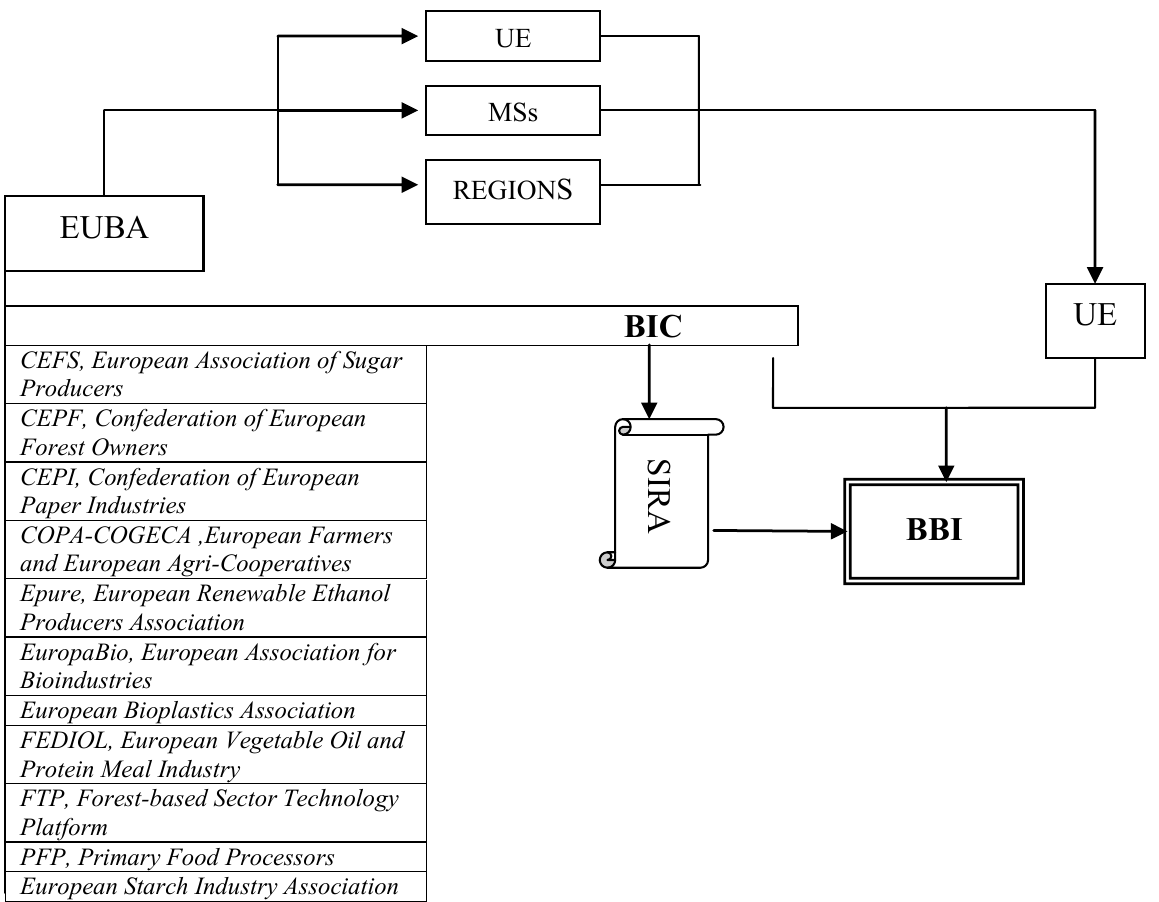
Fig. 2 : The official relationships between the biobased industries and the European Union. Source: own figure on data by http://biconsortium.eu; www.bbi-europe.eu; www.bioeconomyalliance.eu; BIC, 2013